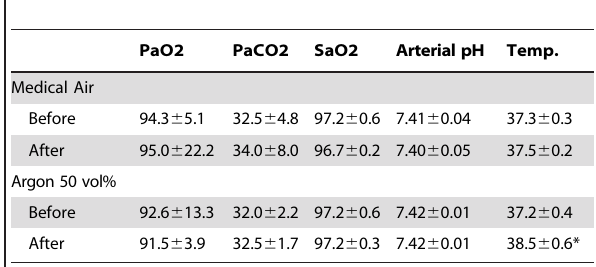
Table 1. Physiological parameters in control rats treated with medical air and rats treated with argon at 50 vol% before and after MCAO-induced ischemia.